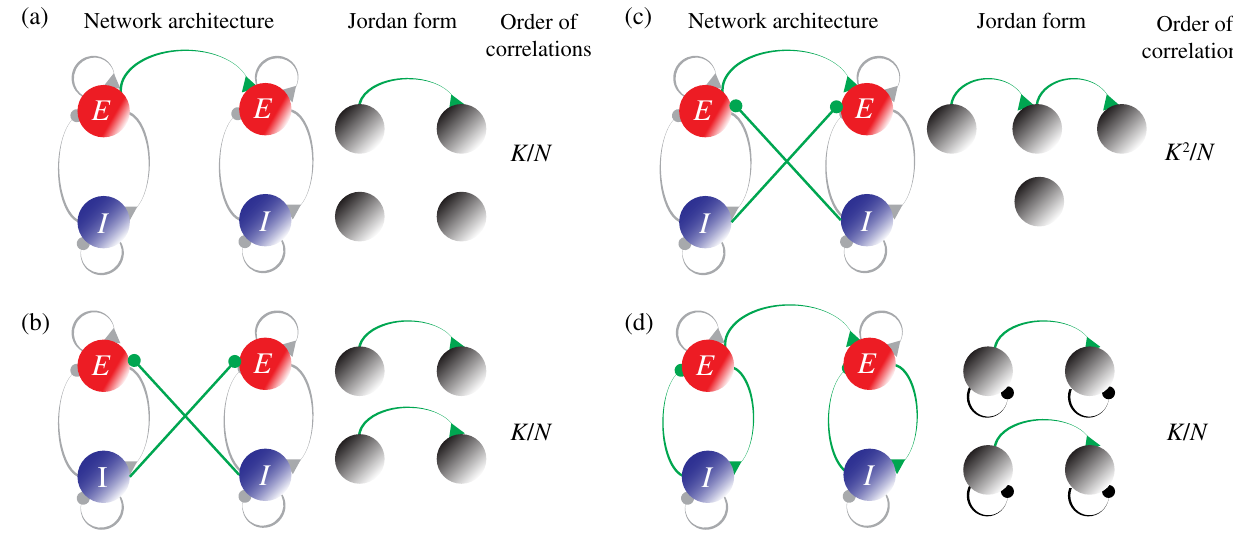
FIG. 7. Examples of networks with four populations and their Jordan representations. Probability of connections are as in Eq. (37). (a) – (c) Left: The network consists of two coupled E - I networks. Gray: Unstructured connections. Green: Spatially modulated connections. Middle: The Jordan representation of the n ¼ 1 Fourier mode of the connectivity (network of the left panel. Right: The scaling of the strongest correlation. (d) Same as (a) – (c) with a population-averaged connectivity matrix as in Eq. (46). Middle: The Jordan form is complex [Eq. (47)]. Black lines correspond to complex